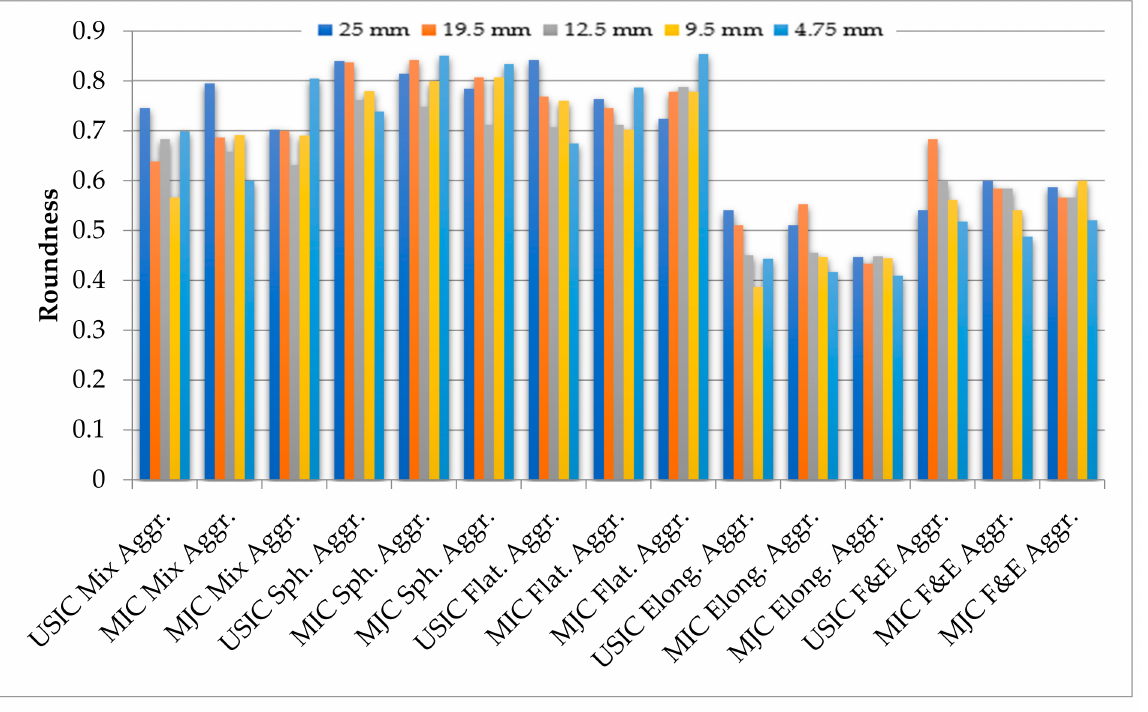
Figure 9. Roundness of different shapes of aggregates and types of crushers. It may be noted from Figure 9 that 25 mm sieve fraction, the mix aggregates indicated high roundness in order of MIC, USIC and MJC. The spherical particles of all sources revealed higher values such as USIC, MIC and MJC, respectively. The flat aggregates of all sources had high values. All other types and sources of aggregates were